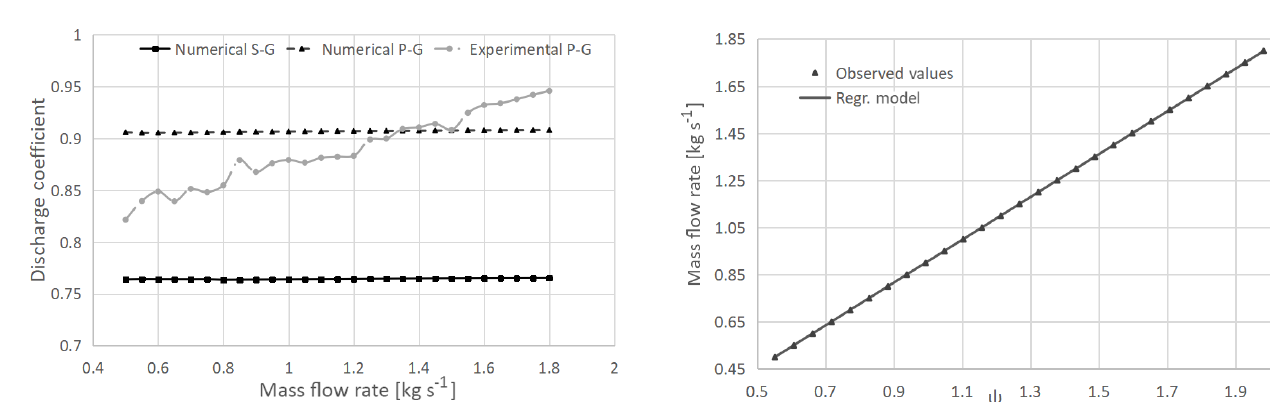
Figure 25. Least squares regression fit, S-G cone.